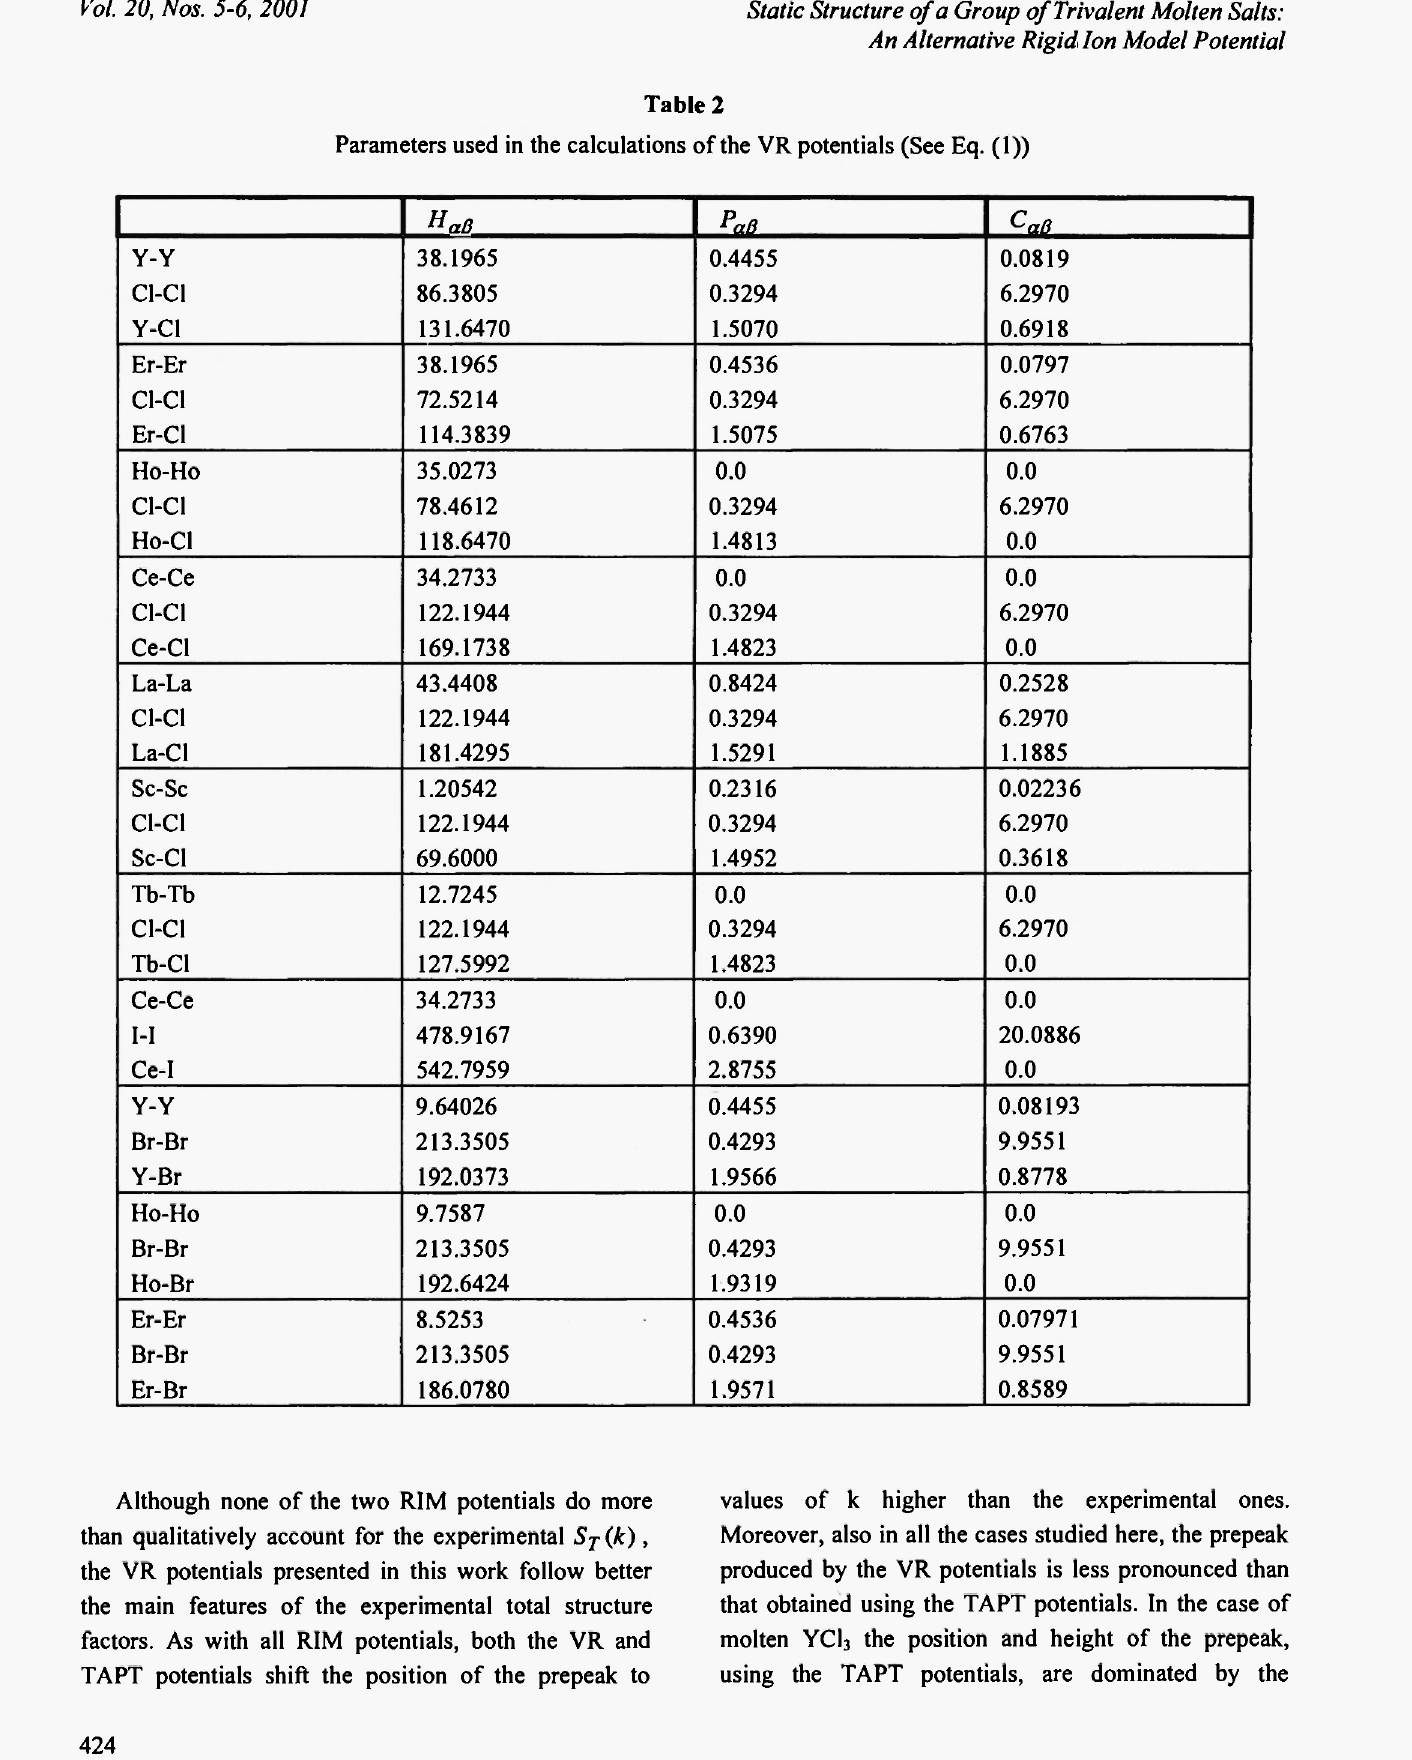
Parameters used in the calculations of the VR potentials (See Eq.